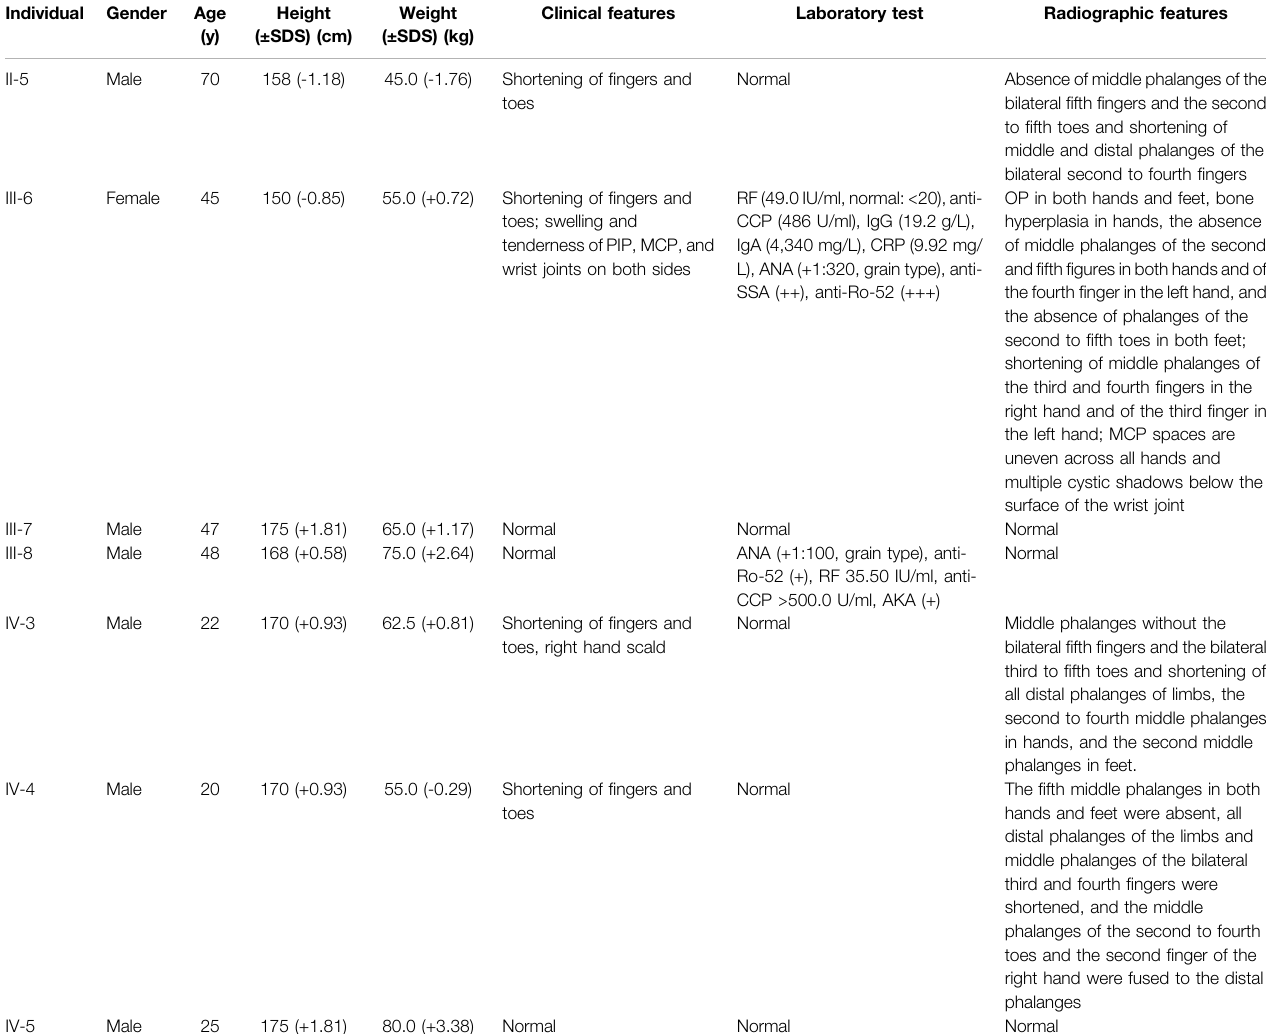
TABLE 1 | Clinical features of tested